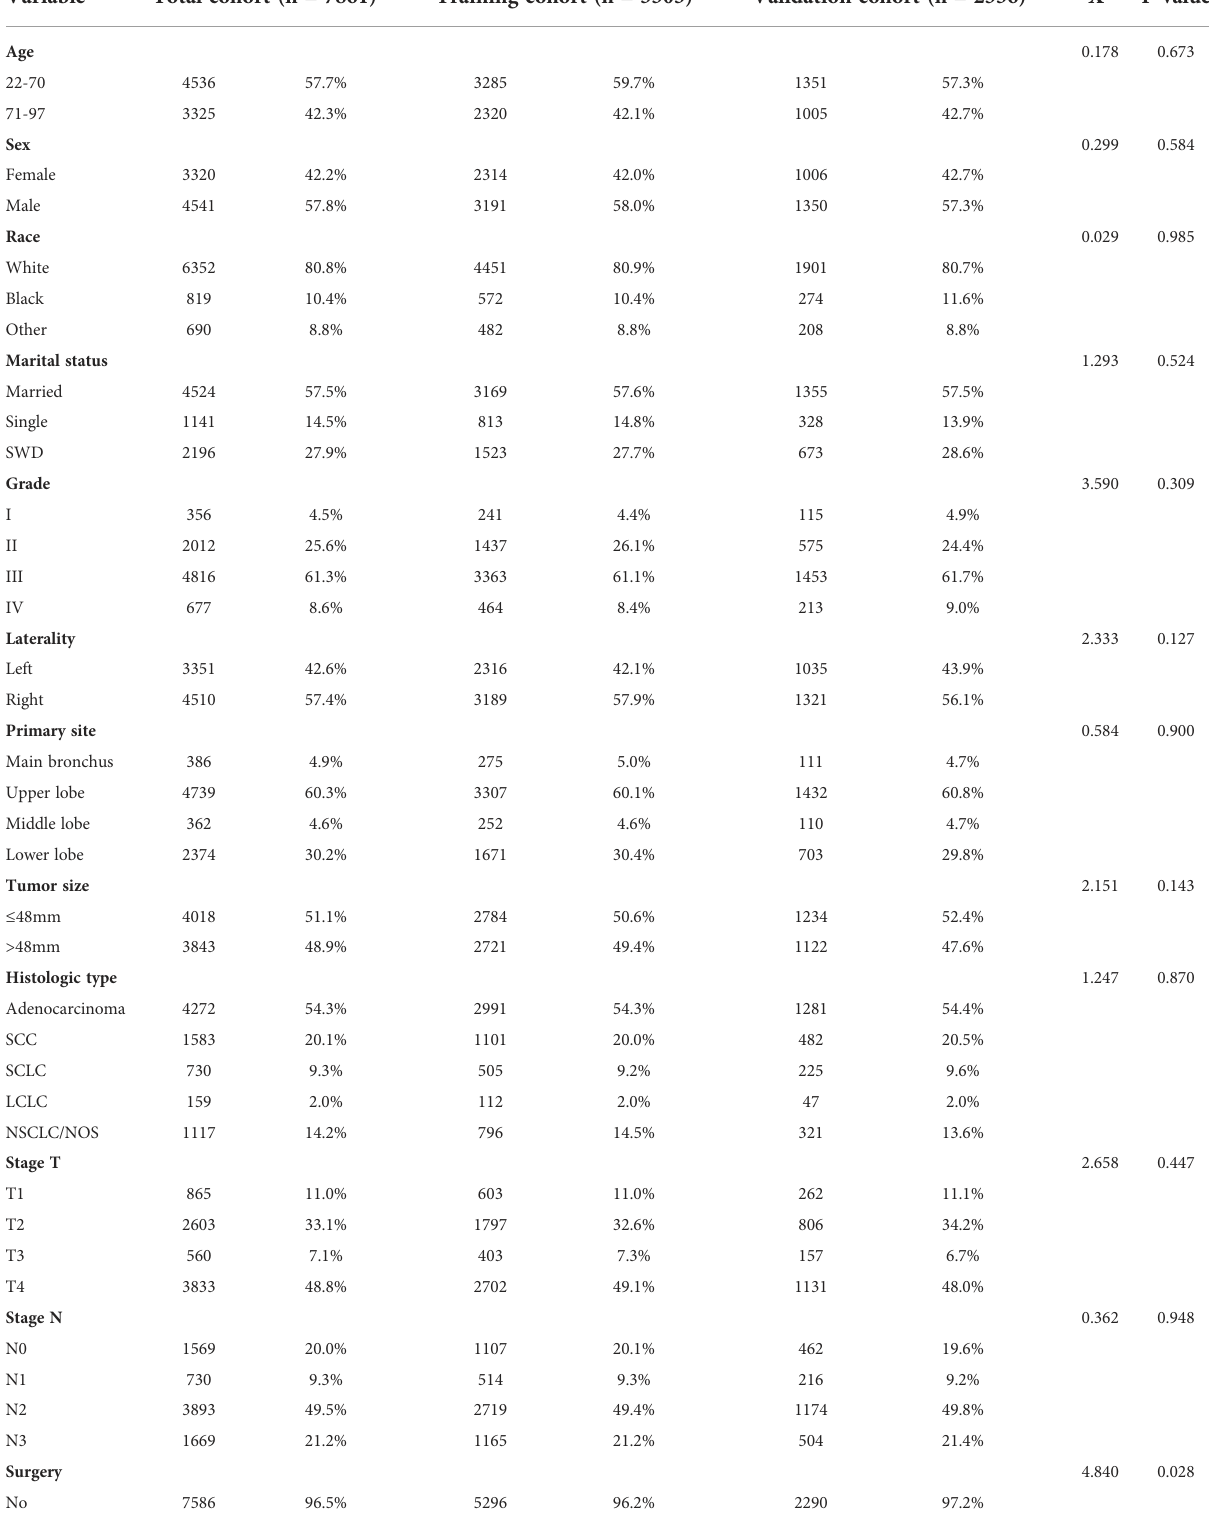
TABLE 1 Demographic and clinicopathological characteristics of the training cohort and validation